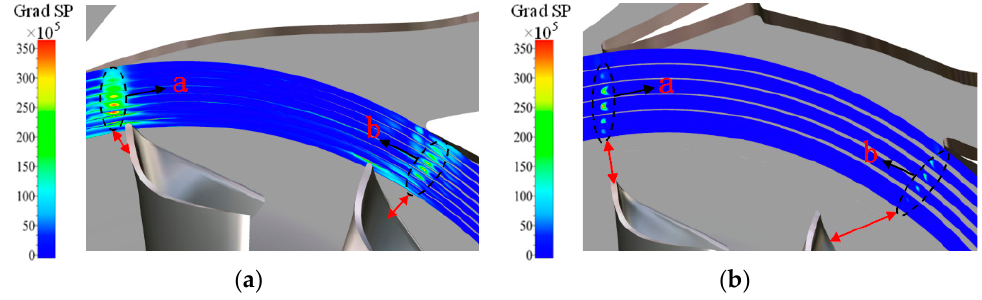
Figure 11. Variation of the shock propagation process: ( a ) base model; ( b ) SSGV model.